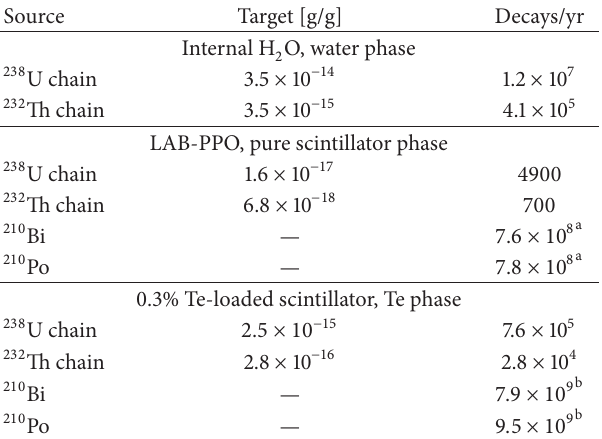
Table 2: Target levels, in g/g, and corresponding decay rates for the internal 238 U- and 232 Th-chain contaminants in the various SNO+ phases. Secular equilibrium has been assumed for all the isotopes except 210 Pb, 210 Bi, and 210 Po. The levels of 210 Bi and 210 Po during the pure scintillator phase and the Te-loaded phase are expected to be out of secular equilibrium due to the intrinsic scintillator contamination and the leaching off of the AV surface. For the 0.3% Te-loaded scintillator the tellurium/polonium affinity component is also included in the 210 Po decays/yr (see